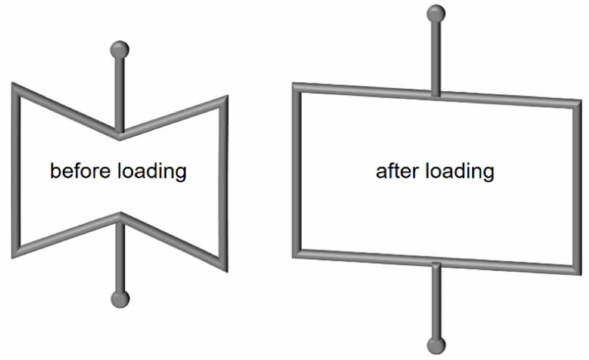
Figure 2. Re-entrant inverse honeycomb